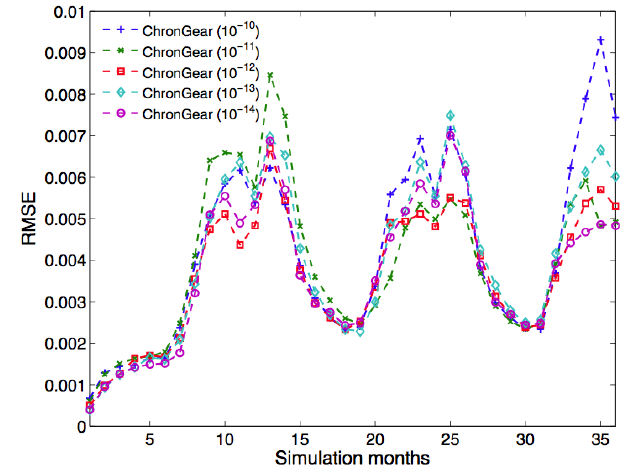
Figure 2. Monthly root mean square Z -score (RMSZ) of temper- ature with respect to an ensemble (denoted by yellow) for experi- ments with barotropic different convergence tolerances. Note that this is subset of Fig. 13 in Hu et al.